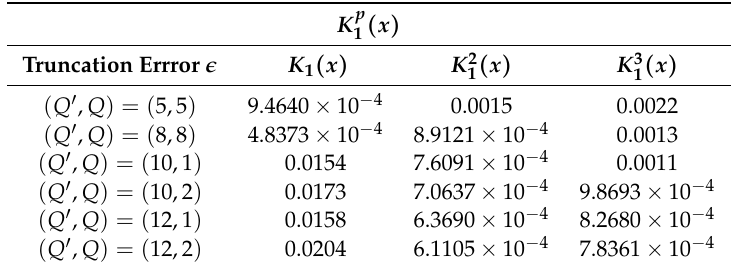
Table 1. The Truncation Error of K p